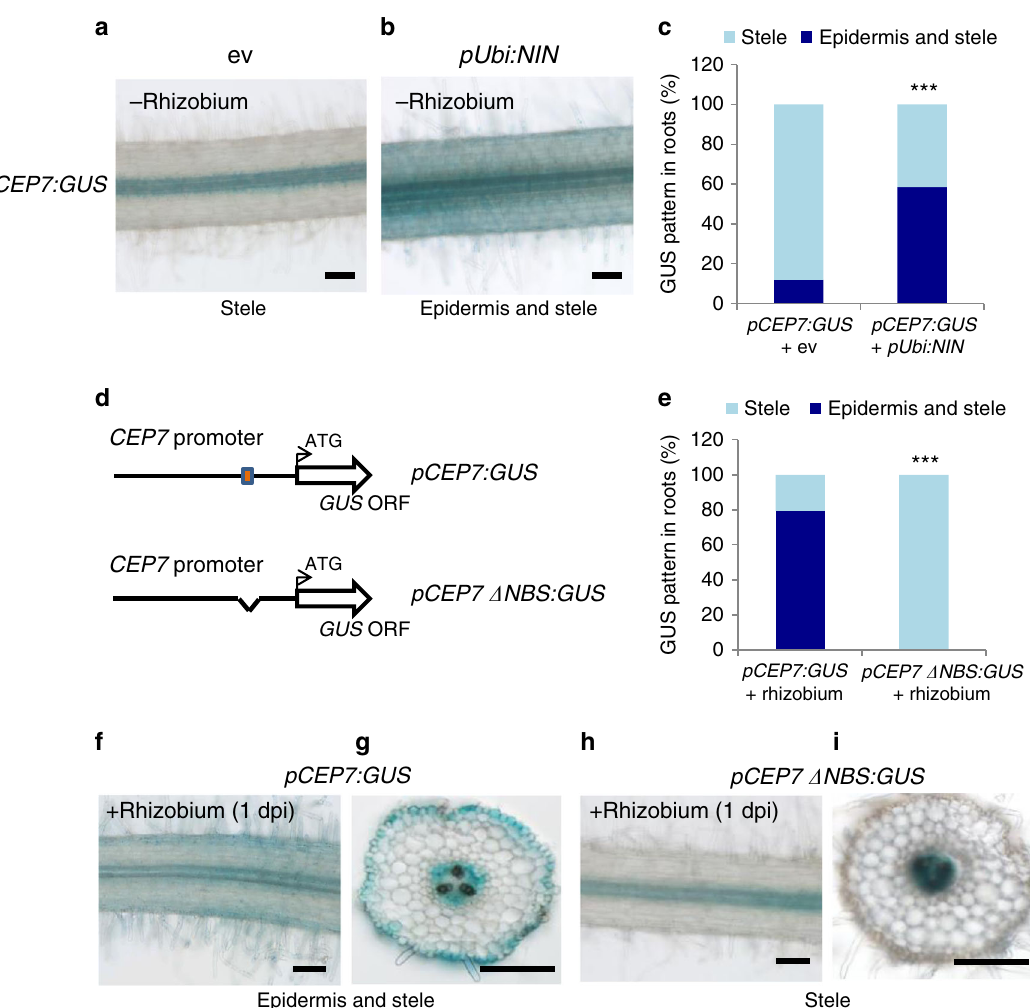
Fig. 5 The NIN-binding site cis -element predicted in the proximal region of the CEP7 promoter is required for its induction by rhizobia. a – c NIN expression driven by the pUbi promoter is suf fi cient to induce the expression of a MtCEP7:GUS fusion in the absence of rhizobium ( b ), compared to an empty vector (ev) control ( a ). Representative images of the GUS expression pattern associated only with the root stele ( “ stele ” ) or with both the root epidermis and stele ( “ epidermis and stele ” ). Wild-type plants were grown in vitro on a nitrogen-free Fåhraeus medium. In c, quanti fi cation of the proportion of roots ( n ≥ 25) showing a GUS expression pattern associated only with the root stele or with both the root epidermis and stele, as described in a , b . d – h The NIN-binding site (NBS) in the proximal region of the MtCEP7 promoter is required for the induction of a MtCEP7:GUS fusion in response to rhizobium. In d , schematic representation of the MtCEP7 promoter, highlighting the predicted NBS cis -element identi fi ed as a red box and the corresponding deletion construct ( pCEP7 Δ NBS:GUS ). In e , quanti fi cation of the proportion of roots ( n ≥ 34) showing a GUS expression pattern associated only with the root stele ( “ stele ” ) or with both the root epidermis and stele ( “ epidermis and stele ” ), as described in f – i . In f , g , representative images of the GUS expression pattern associated only with the root stele or with both the root epidermis and stele of pCEP7 Δ NBS:GUS 1 day post rhizobium inoculation (dpi) in longitudinal ( f ) or transversal ( g ) sections. In h , i , representative images for the same GUS expression patterns for MtCEP7:GUS roots 1 dpi in longitudinal ( h ) or transversal ( i ) sections. In a , b , f – i , a minimum of eight independent roots were analyzed for each time point from three independent experiments. Images show the GUS staining as a blue signal in bright fi eld microscopy. Scale bars = 100 µ m. In c , e , Fisher exact test was performed to assess signi fi cant differences in the proportion of roots ( n ≥ 25) showing the different GUS expression patterns between the NIN overexpressing ( c ), or NBS-deleted MtCEP7: GUS ( e ) roots, and the control, as indicated by asterisks (*** α <